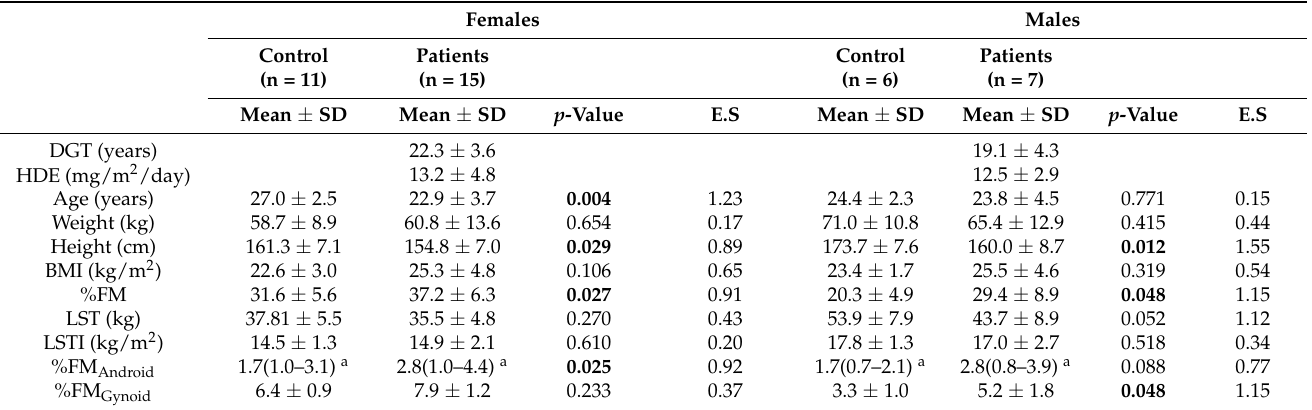
Table 1. Descriptive characteristics and body composition separated by sex and group of the study